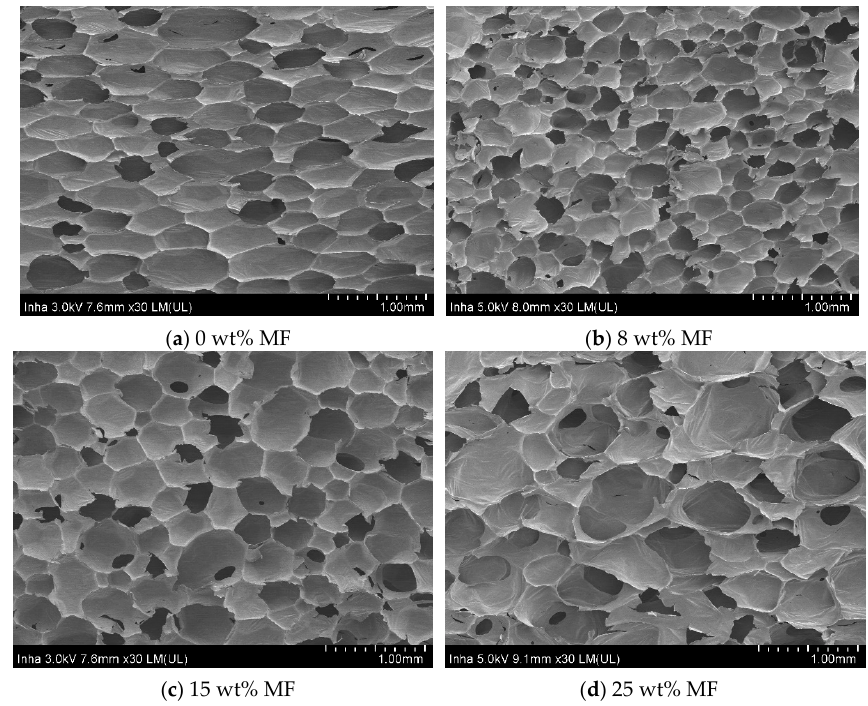
Figure 5. Density of polyurethane / melamine-formaldehyde (PU / MF) foams as a function of MF content, reproduced from [97] with permission, copyright Springer Nature, 2016.